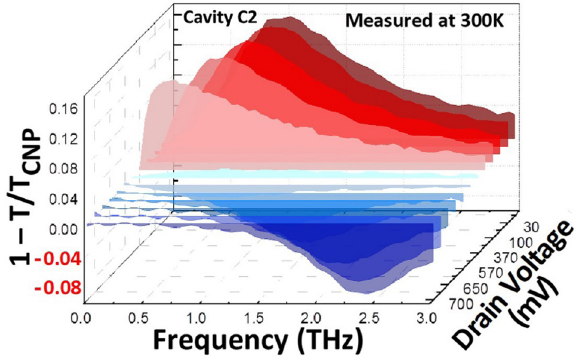
Figure 9: Drain bias dependent extinction spectra of the graphene structures. Spectra measured in cavity C2 of device A-DGG1 for fixed V g2 − V CNP2 = 3 V and V g1 = V CNP1 when varying V d . Adapted